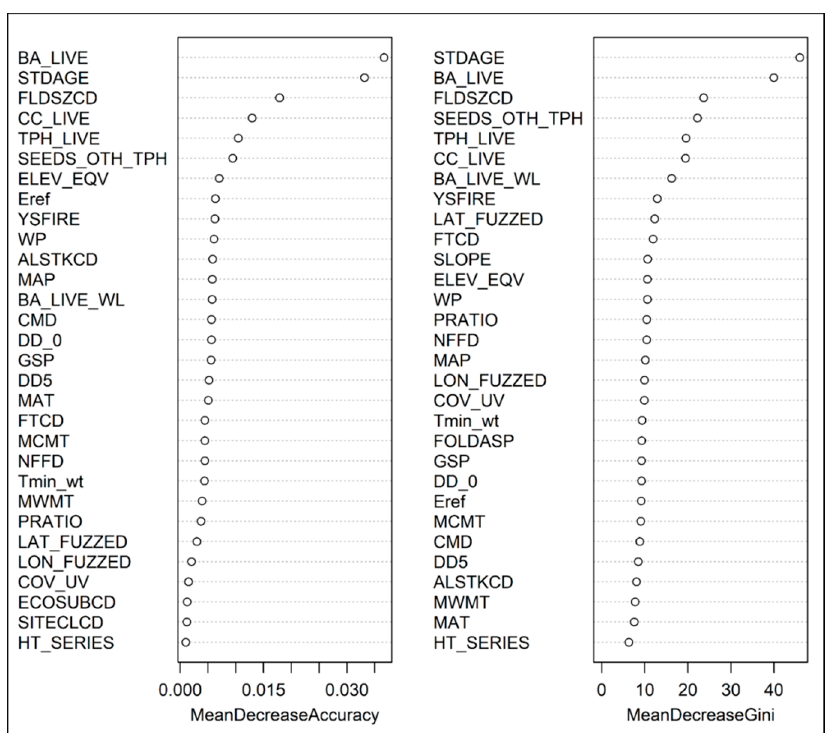
Figure 2. Variable importance plots produced by random forests model of western larch seedling presence, measured as each variable’s (Table 1) mean decrease in overall accuracy and the Gini index. The most important predictor variables have the highest decrease in overall accuracy.